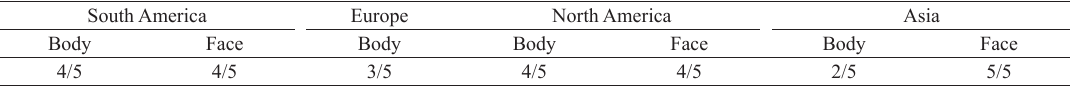
Table 7. Number of attributes (out of 5 evaluated) for which sensorial analysis results were predicted by the ANN model with precision higher than 60%. South America Body